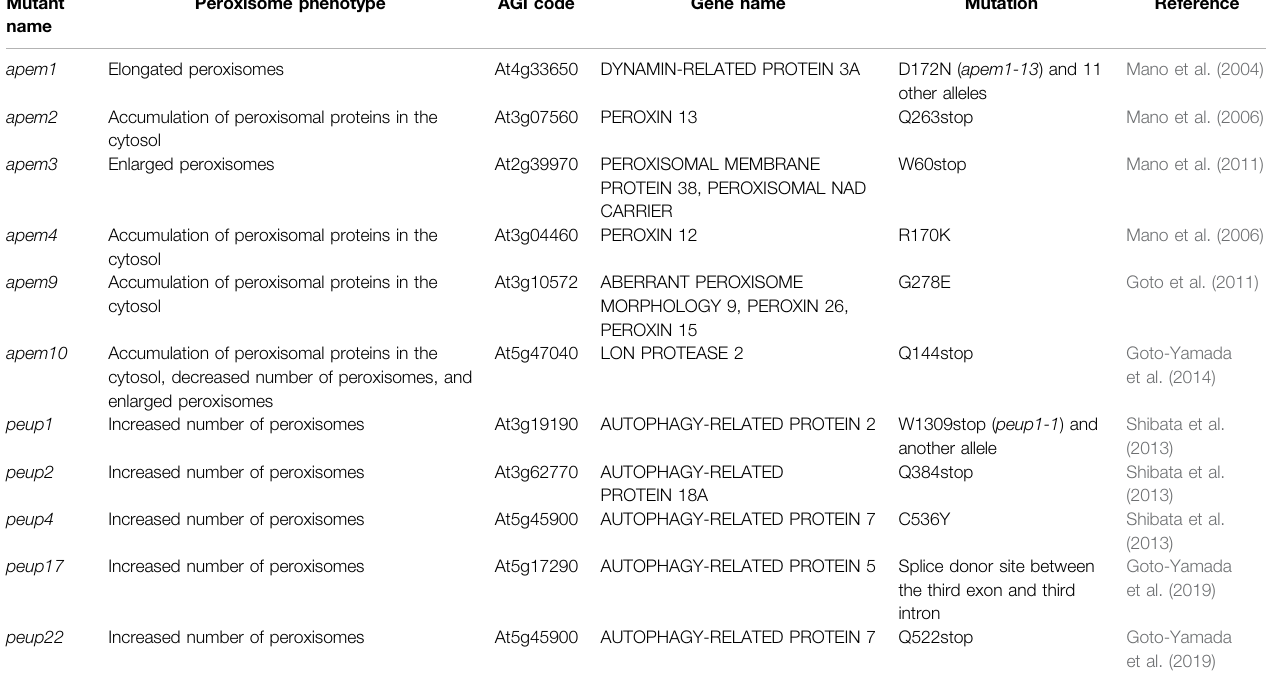
TABLE 1 | Phenotypes and causative genes in apem and peup mutants.